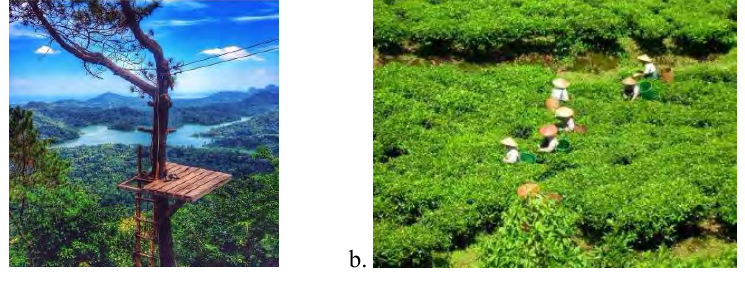
Figure 13c. Photospot in Kalibiru (author, 2016) Figure 14d. Teawalk in Nglinggo (Bernadi, 2015)